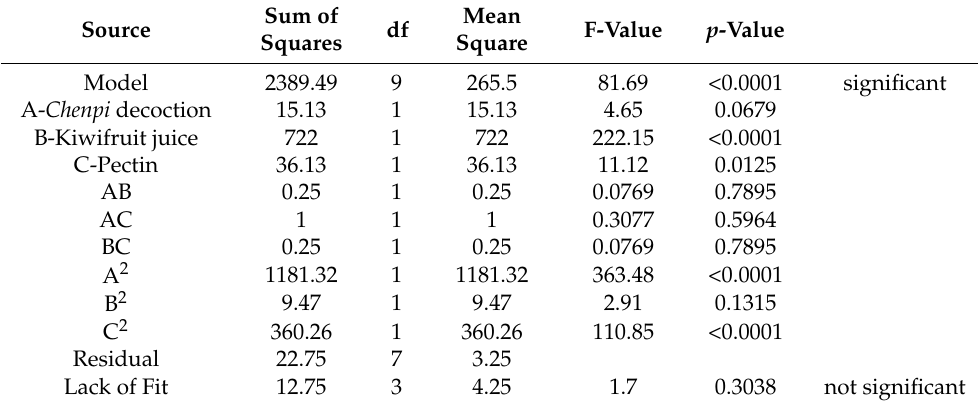
Table 4. Variance analysis of fitted model 1